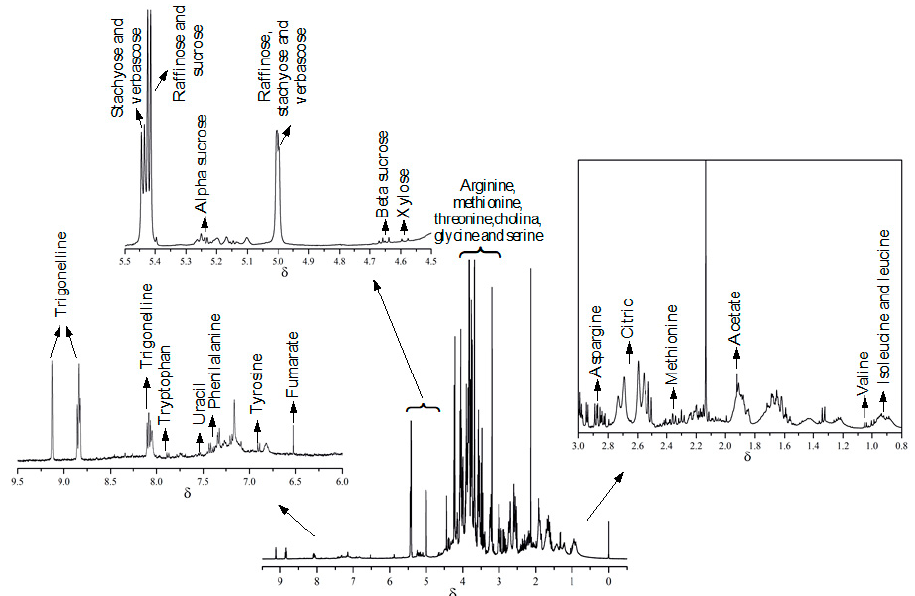
Figure 2. 1 H-NMR spectra obtained at 9.4 T (400 MHz for 1H) under initial conditions ( t = 0) for TAA Dama cultivar.